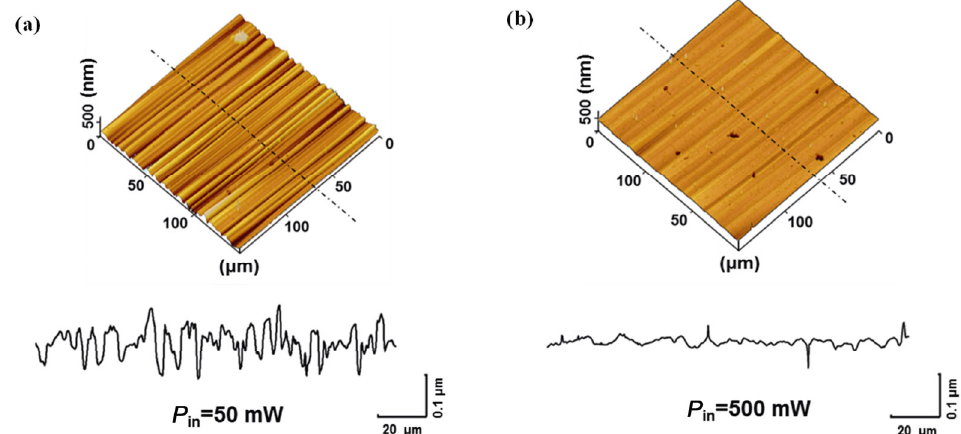
Fig. 13 Typical SPM images of randomly sampled wear profiles on SiC disk after 100 m-sliding in NDP–COOH (0.1 wt%) with P = (a) 50 mW and (b) 500 mW. Arithmetic average roughness of (a, b) are 30.79 and 7.97 nm, respectively. Surface in profile of section marked by dashed line is shown at bottom of each